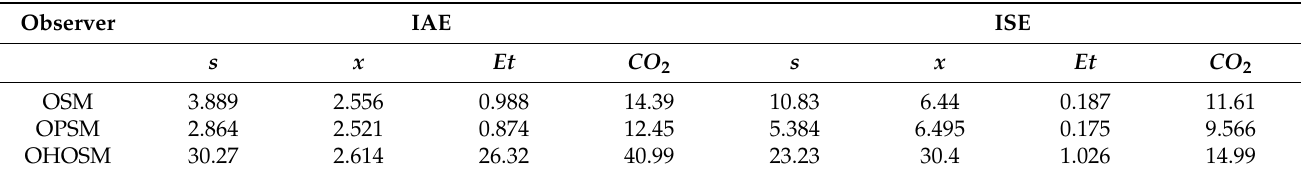
Table 5. Estimation error index.